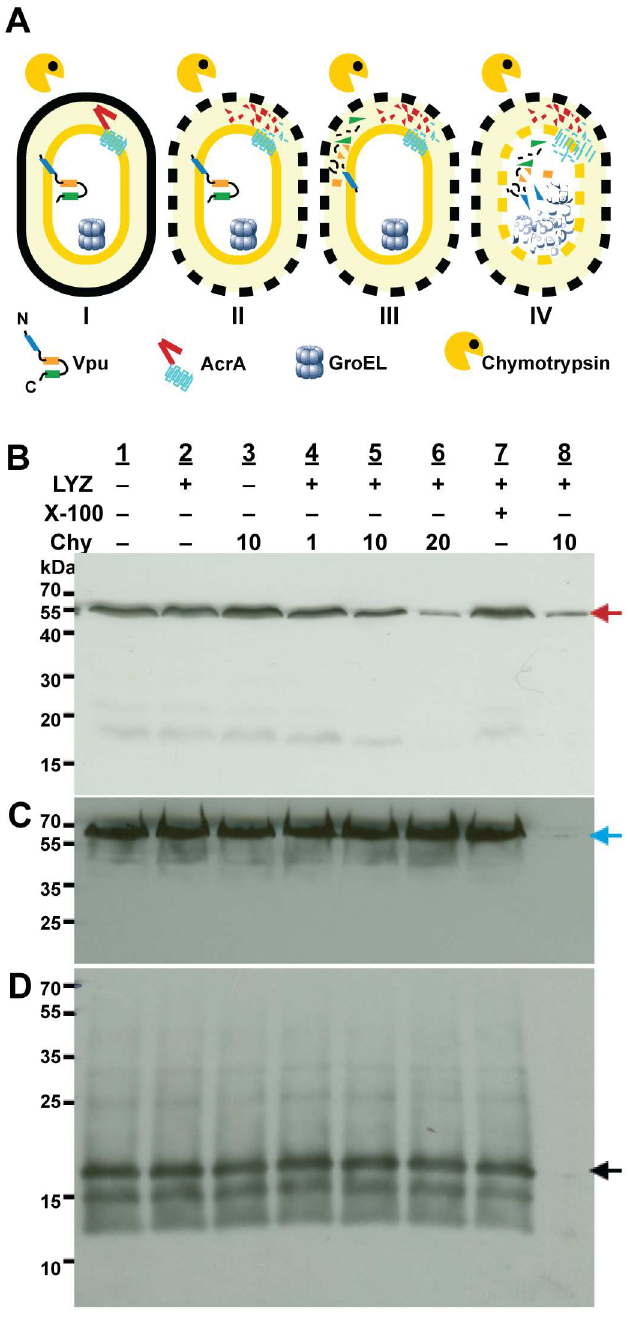
Fig 5. Vpu is inserted into the bacterial inner membrane with its C-terminal domain within the cytoplasm. Panel A depicts the possibleoutcomes when E . coli cells (I) and protoplasts(II III and IV) that express Vpu are digestedwith chymotrypsin alone (I-III) and in the the presenceof Triton X-100 (IV). If the C- terminaldomain of Vpu is protected by the inner membrane(I and II), it is expectedto be resistant to chymotrypsin digestion, similar to the case of the cytoplasmic resident protein GroEL. If the C-terminal domain of Vpu is exposedat the periplasmic space of the cells (III), it is expectedto be digestedin the same way as AcrA. All three proteinsshould undergochymotrypsin cleavagewhen the inner membranes are permeabilized by the additionof Triton X-100 (IV). E . coli cells (lanes 1 and 3) and protoplasts (lanes 2 and 4–8) were incubatedwithout chymotrypsin (lanes 1, 2, and 7) or with the indicatedconcentrations of chymotrypsin ( μ g/ mL); in the presenceof 1% Triton X-100 (lanes 7 and 8) or its absence(lanes 1–6). Followingtreatments, cells were solubilizedin the presenceof SDS sample buffer and protein samples were resolved by